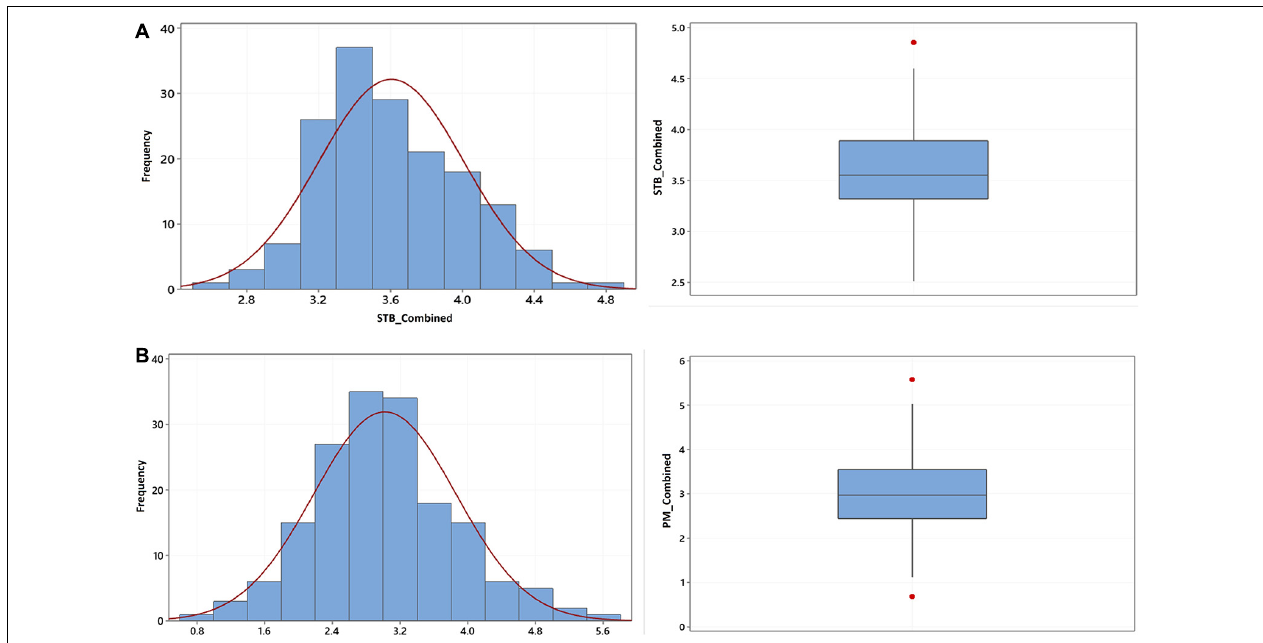
FIGURE 1 | Frequency distribution (left) and box plot (right) of the BLUEs of (A) STB and (B) PM diseases scores combined from five environments using 175 winter wheat genotypes.